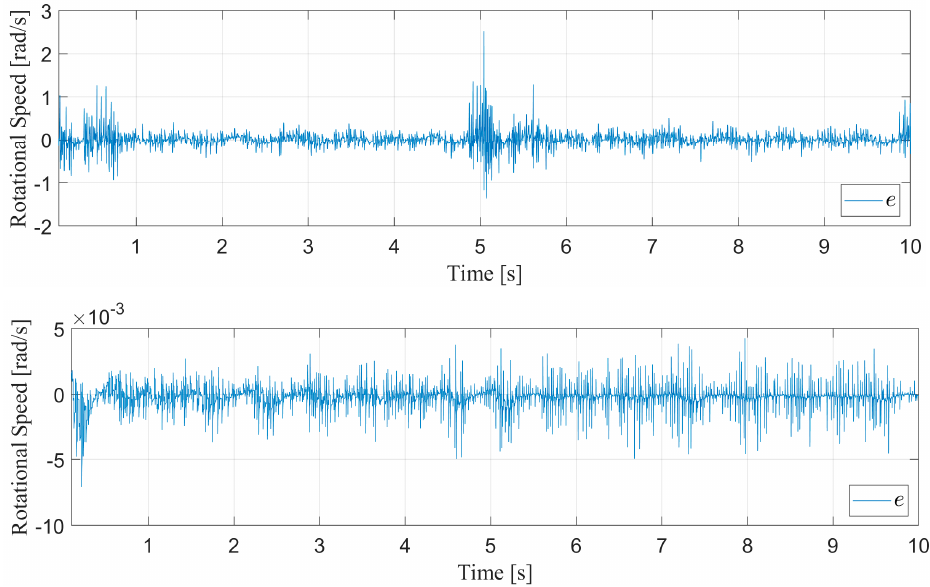
Figure 12. Speed control errors of a vector controller (above) and nonlinear controller (below) in response to wind turbu ‐ lence.